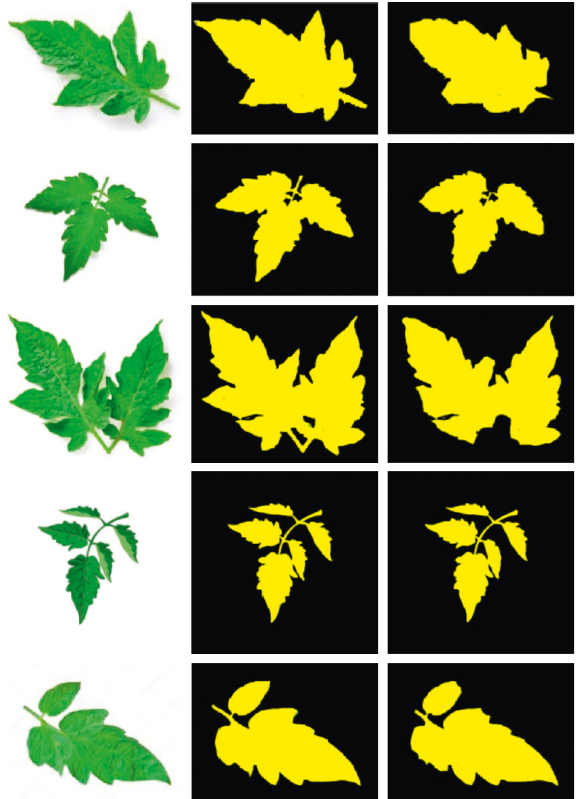
Figure 6: Some example images we used during our experiments: column 1 shows original images, column 2 shows ground truth data, and column 3 shows segmentation images with the proposed SLS